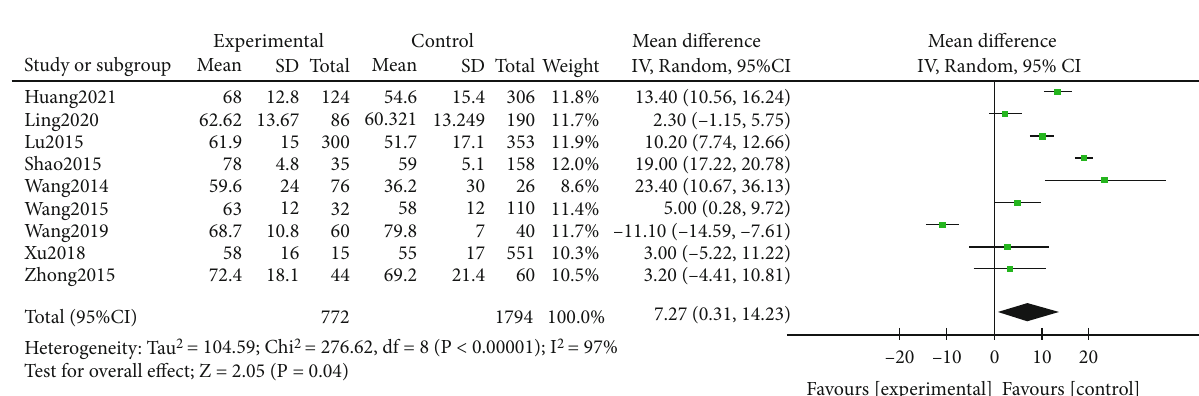
Figure 4: Estimated MD summary for ESR.